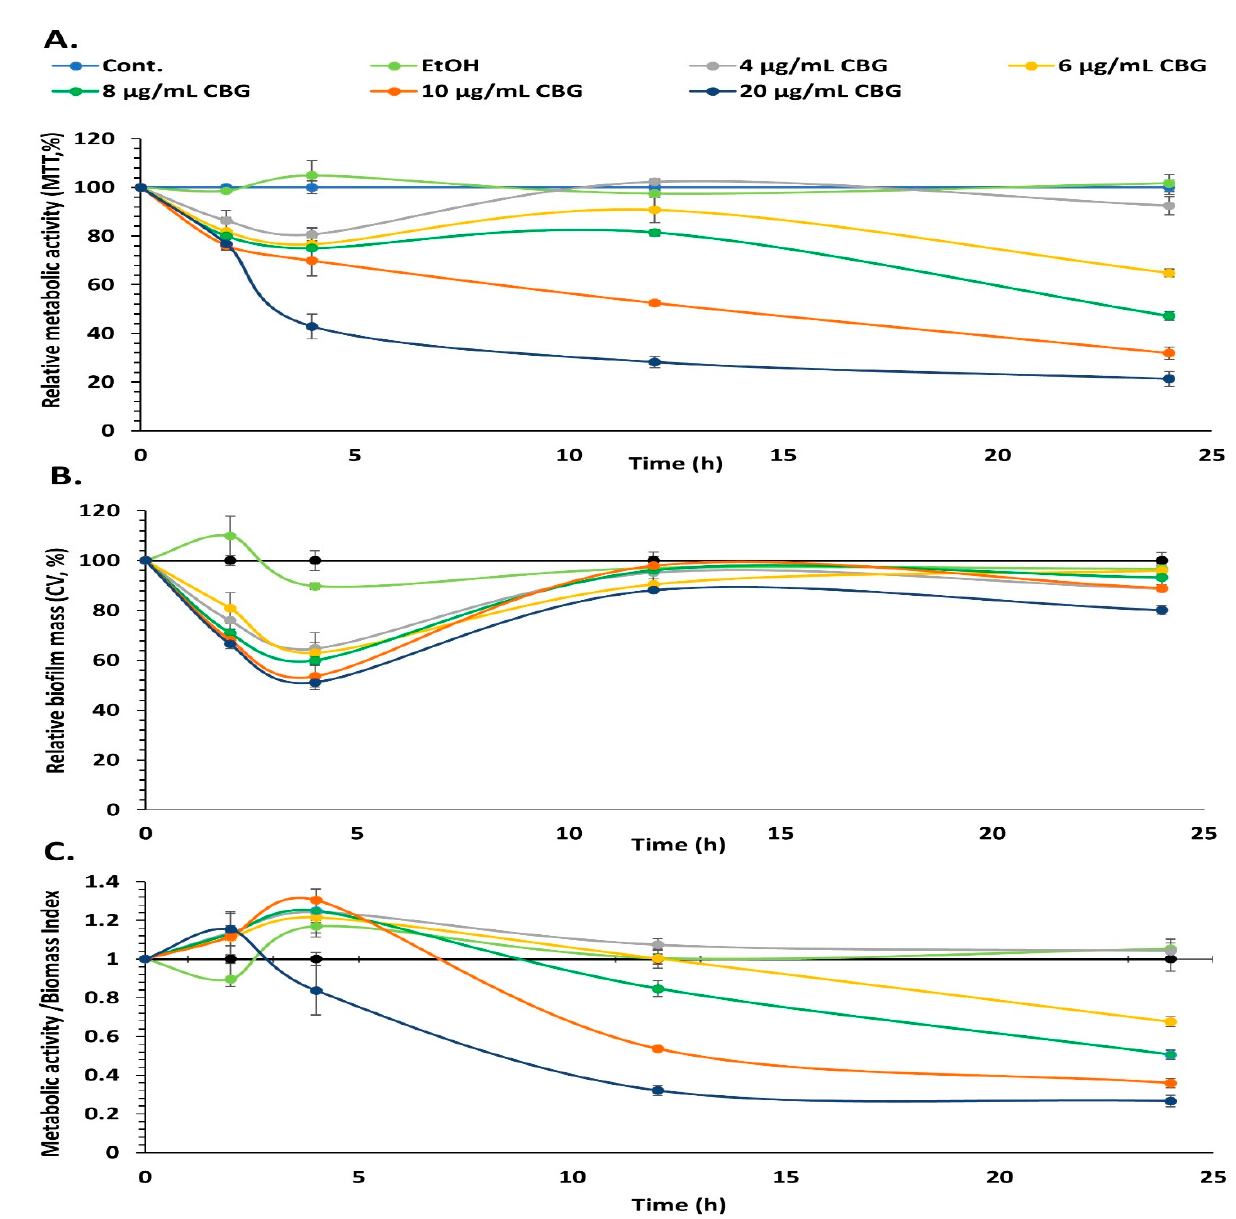
Figure 7. CBG decreases the metabolic activity of preformed biofilms. S. mutans was allowed to form biofilms for 24 h prior to exposure to various concentrations of CBG, and the biofilm metabolic activity ( A ) and biofilm mass ( B ) were measured at various time points using the MTT assay and CV staining method, respectively. ( C ) The metabolic activity/biofilm mass index of samples presented in A and B. n = 3.